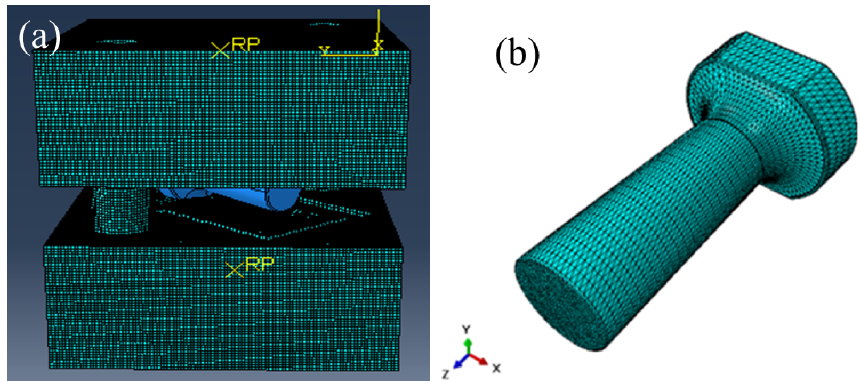
Figure 1. Model of blade isothermal die forging: ( a ) simulation assembly illustration and ( b ) primary mesh of billet.